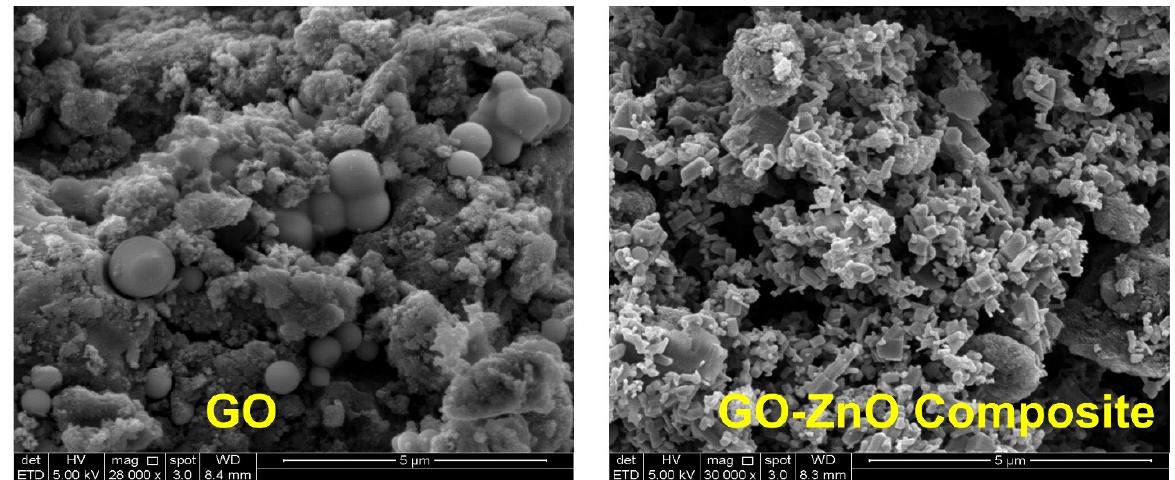
Figure 3. SEM analysis of (i) GO and, (ii) GO-ZnO composite.